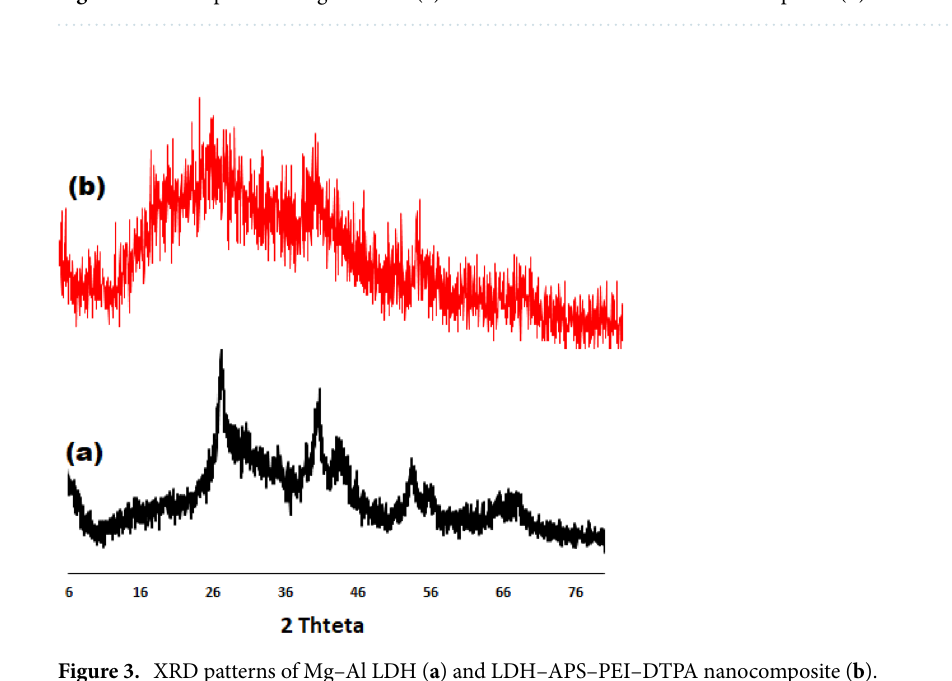
Figure 2. FTIR spectra of Mg–Al LDH ( a ) and LDH–APS–PEI–DTPA nanocomposite ( b ).